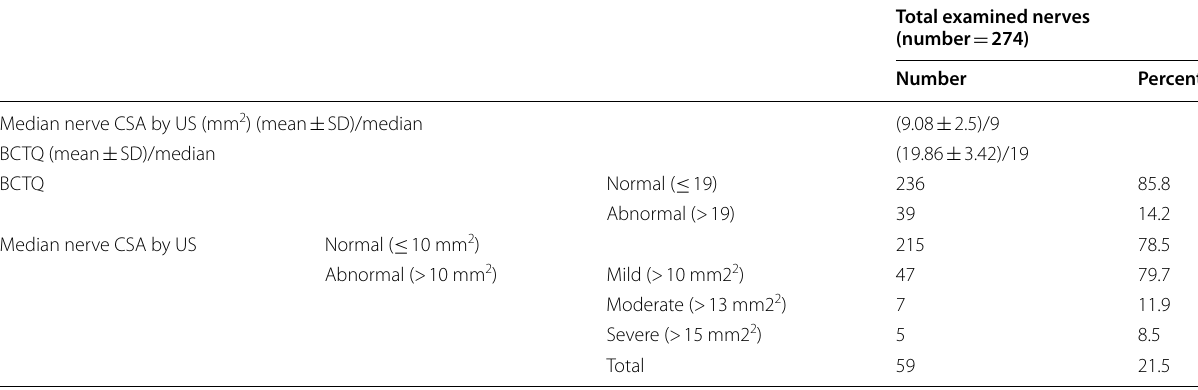
Table 2 Clinical characteristics of total